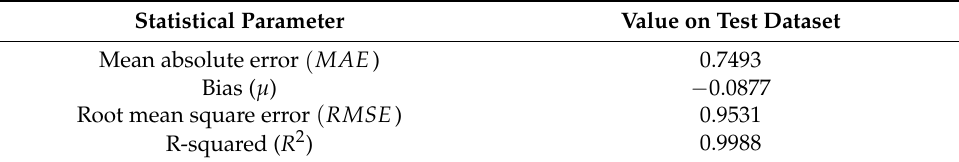
Table 6. Regression model statistical performance.